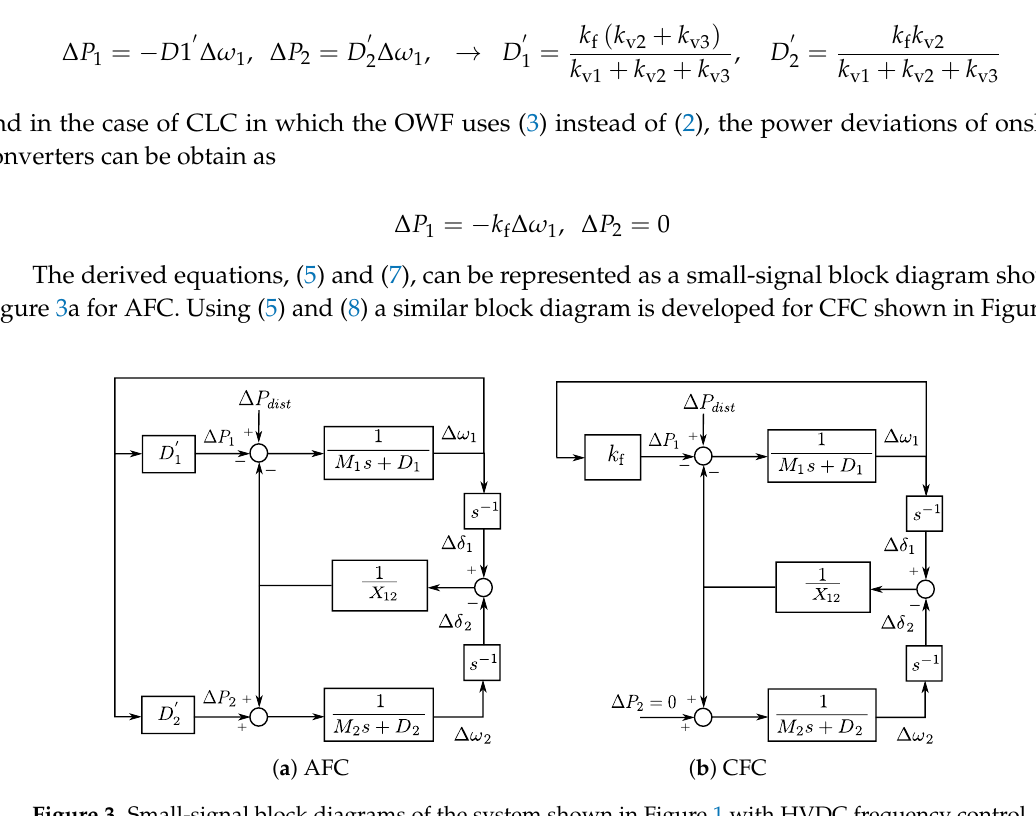
Figure 3. Small-signal block diagrams of the system shown in Figure 1 with HVDC frequency